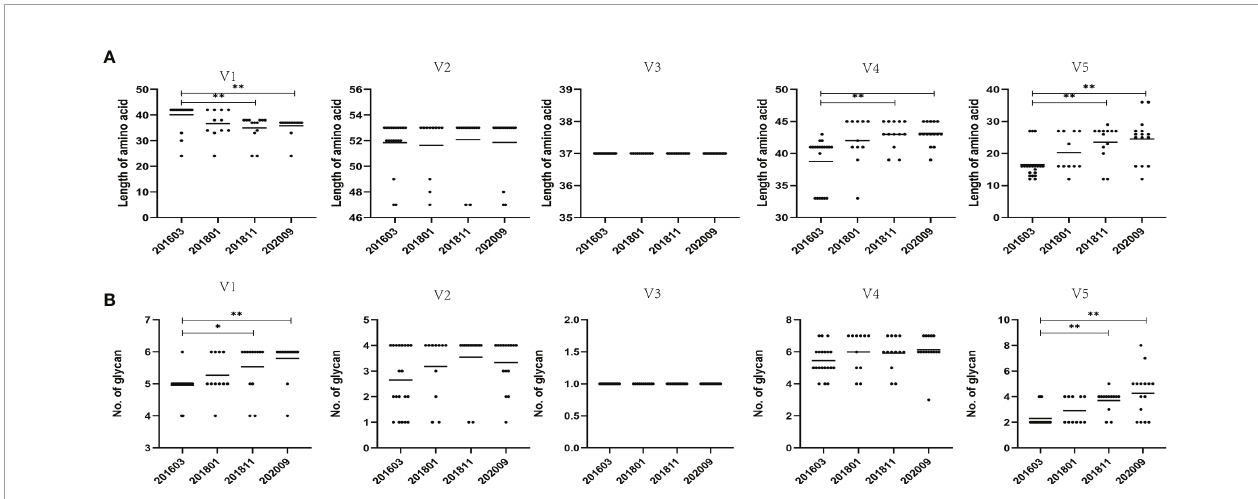
FIGURE 2 | Comparison of amino acid length and PNGS throughout the V1 – V5 regions among different sampling data. (A) Comparison of amino acid length of the V1 – V5 regions, indicating signi fi cant differences in amino acid lengths of V1, V4, and V5 among different time points. (B) Comparisons of glycan number of the V1 – V5 regions, showing signi fi cant differences in glycan number of V1 and V5 among different time points. Representative data are shown (*p < 0.05; **p <